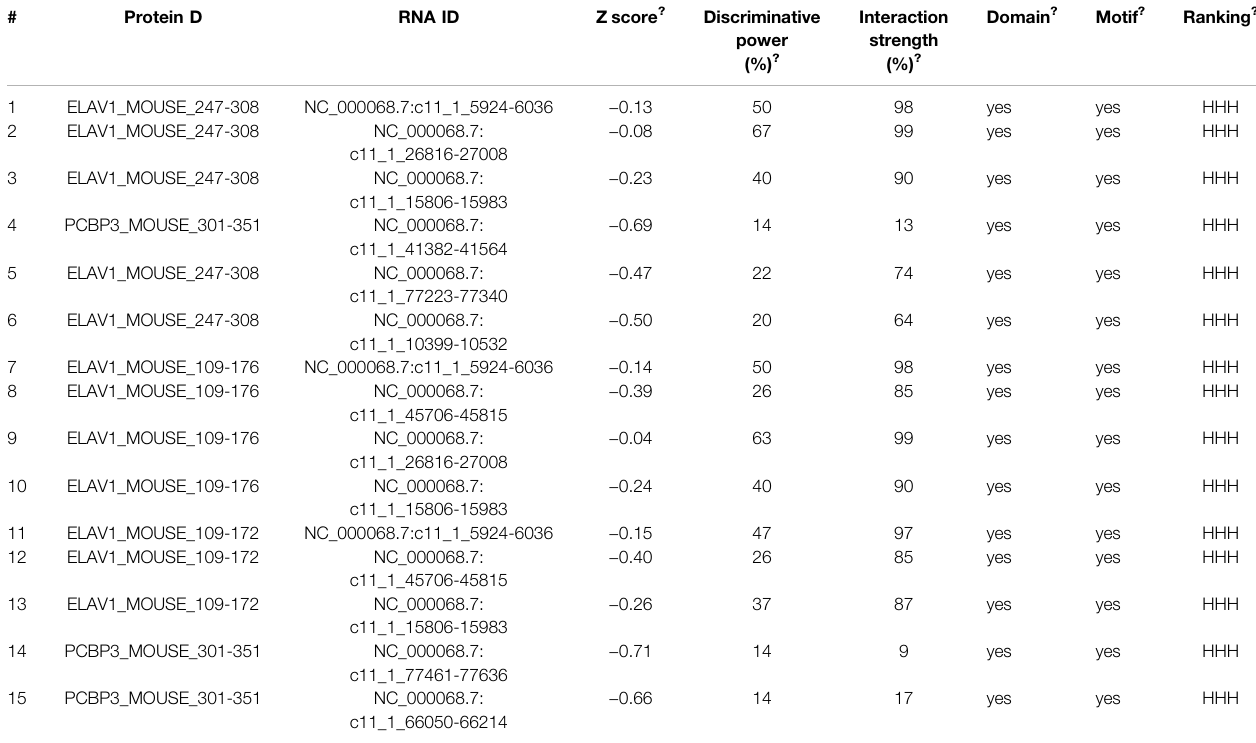
TABLE 5 | Potential proteins may interact with PFKFB3 mRNA through the catRAPID algorithm. # Protein